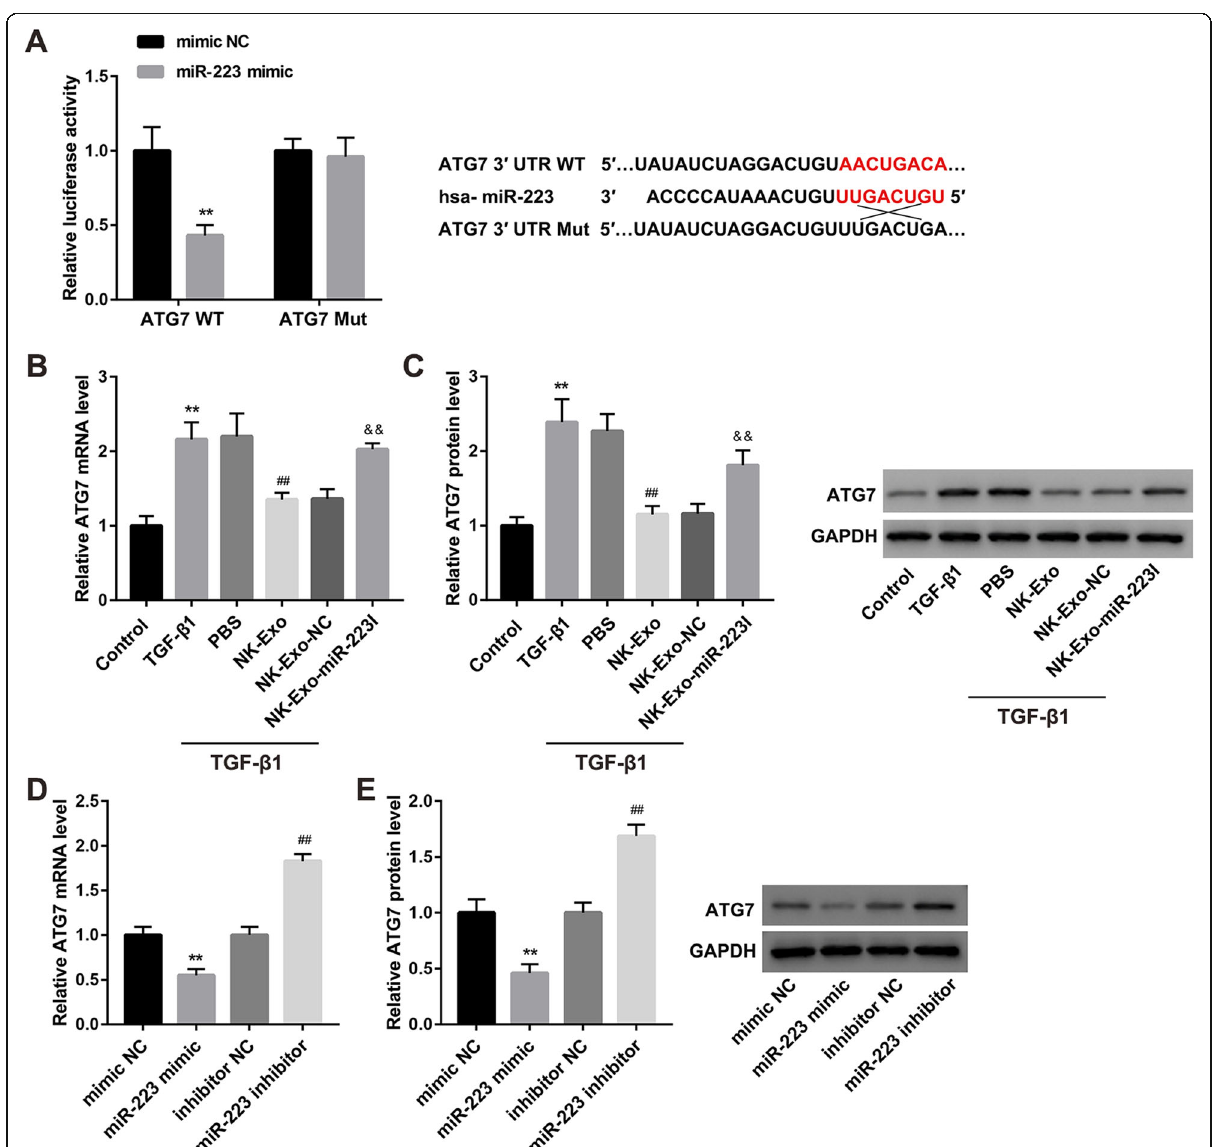
Fig. 3 NK-Exo-mediated transfer of miR-223 inhibited autophagy by targeting ATG7. a The direct binding of miR-223 to ATG7 3 ′ -UTR was verified by dual-luciferase reporter assay. ** P < 0.01 vs. mimic NC. The mRNA (b) and protein (c) levels of ATG7 in LX-2 cells in the groups of Control, TGF- β 1, TGF- β 1 + PBS, TGF- β 1 + NK-Exo, TGF- β 1 + NK-Exo-NC, and TGF- β 1 + NK-Exo-miR-223I. ** P < 0.01 vs. Control; ## P < 0.01 vs. TGF- β 1 + PBS; && P < 0.01 vs. TGF- β 1 + NK-Exo-NC. The mRNA (d) and protein (e) levels of ATG7 in LX-2 cells transfected with mimic NC, miR-223 mimic, inhibitor NC, and miR-223 inhibitor. ** P < 0.01 vs. mimic NC; ## P < 0.01 vs. inhibitor NC. The data are presented as the mean ± standard deviation (n =